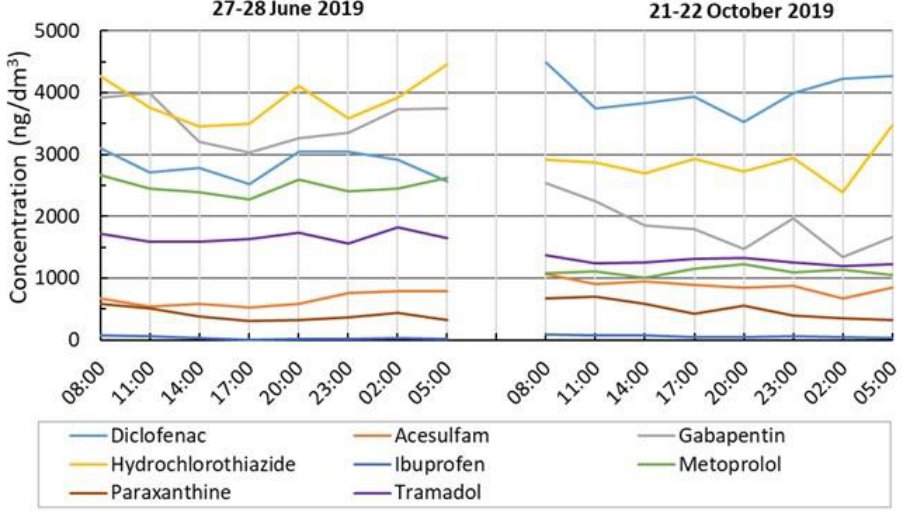
Figure 7. Water quality of the Hnevkovice WWTP (wastewater treatment plant) effluent: diclofenac,